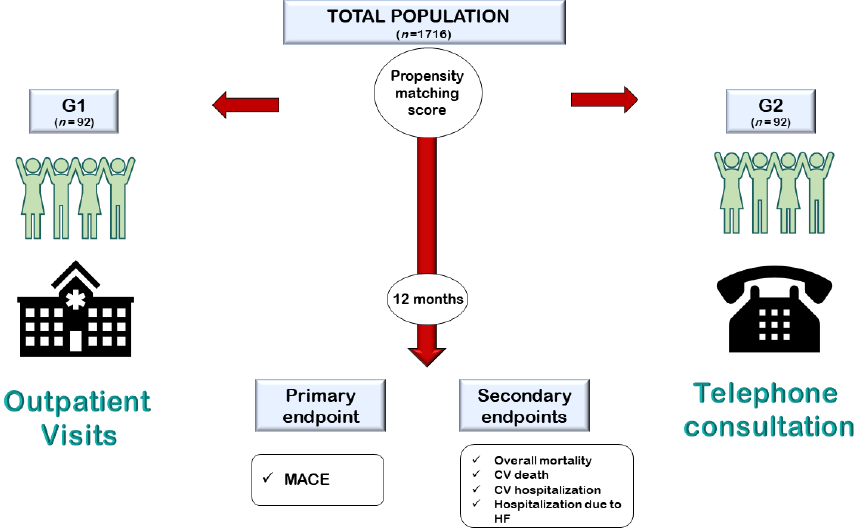
Figure 1. Representation of the study design. G1: group 1; G2: group 2; MACE: major adverse cardiovascular events; CV: cardiovascular; HF: heart failure.